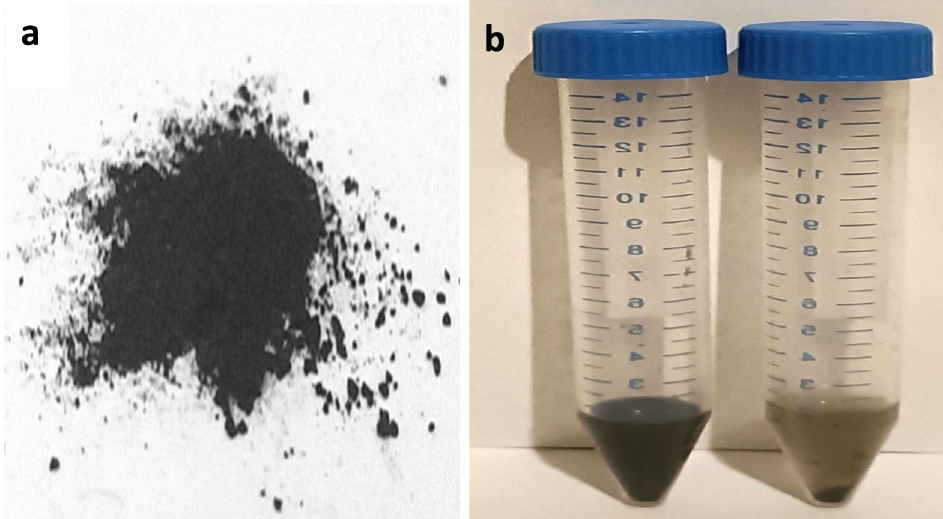
Fig. 1 a A photograph of the extracted sepia melanin powder, b a photograph of SM suspended in Hepes buffer at pH 7 (right) and SM-NP-Tw